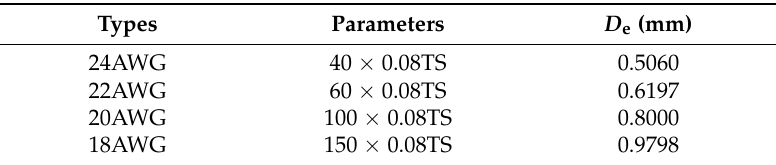
Figure 1. ( a ) Photograph and ( b ) structure diagram of a parallel helical sensing cable (PHSC). Table 1. Four types of PHSC.